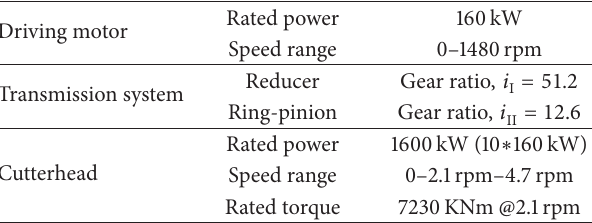
Table 1: Technical parameters of TBM cutterhead driving system.